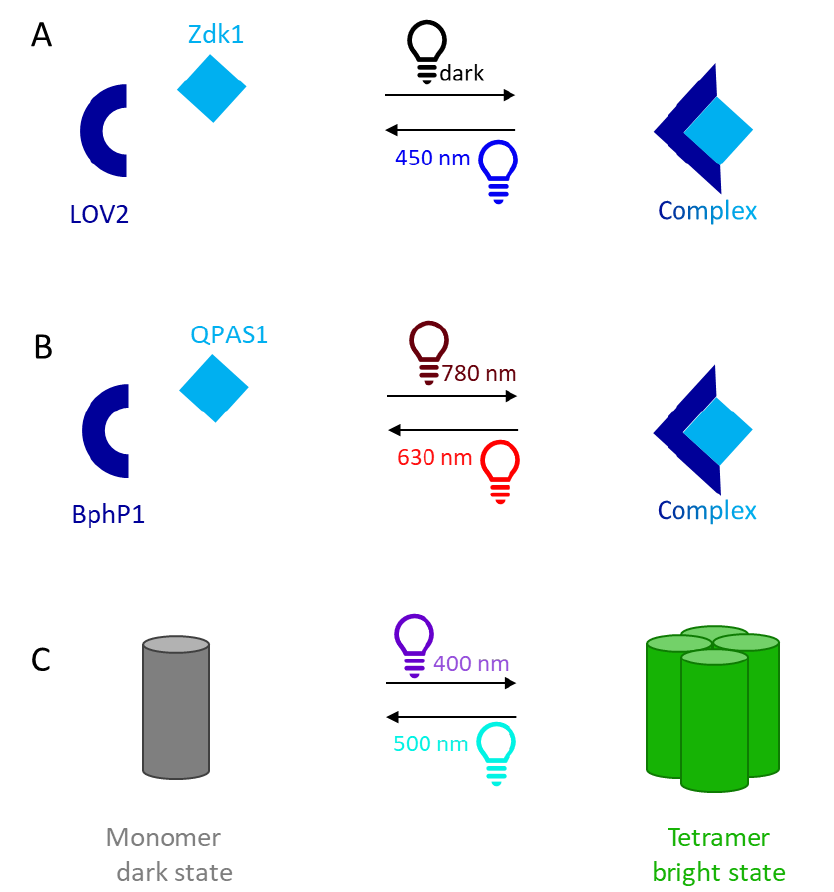
Figure 1. Schematic representation of three photo-switchable systems. ( A ) The Zdk1 protein binds to dark-state LOV2 and is released by irradiation with blue light. The binding and dissociation of the Zdk1 is dependent on the conformation of LOV2. LOV2 = light–oxygen–voltage 2, Zdk1 = Zdark1. ( B ) The QPAS1 protein binds to BphP1 when exposed to near-infrared light and dissociates when exposed to red light (or darkness, not shown). BphP1 = bacterial phytochrome photoreceptor P1 from Rhodopseudomonas palustris , QPAS1 = engineered partner for BphP1. ( C ) The single-component system Dronpa145N undergoes light-dependent oligomerization and dissociation. Excitation with cyan light favors the monomeric protein form, whereas violet light causes the protein to assemble into tetramers. This change in oligomerization state is accompanied by a change in protein fluorescence.